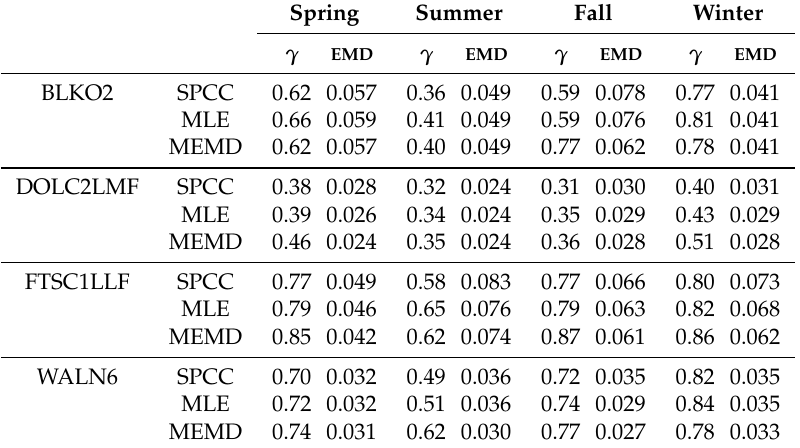
Table 2. EMD between the empirical bivariate CDF and its simulated CDFs. Spring Summer Fall